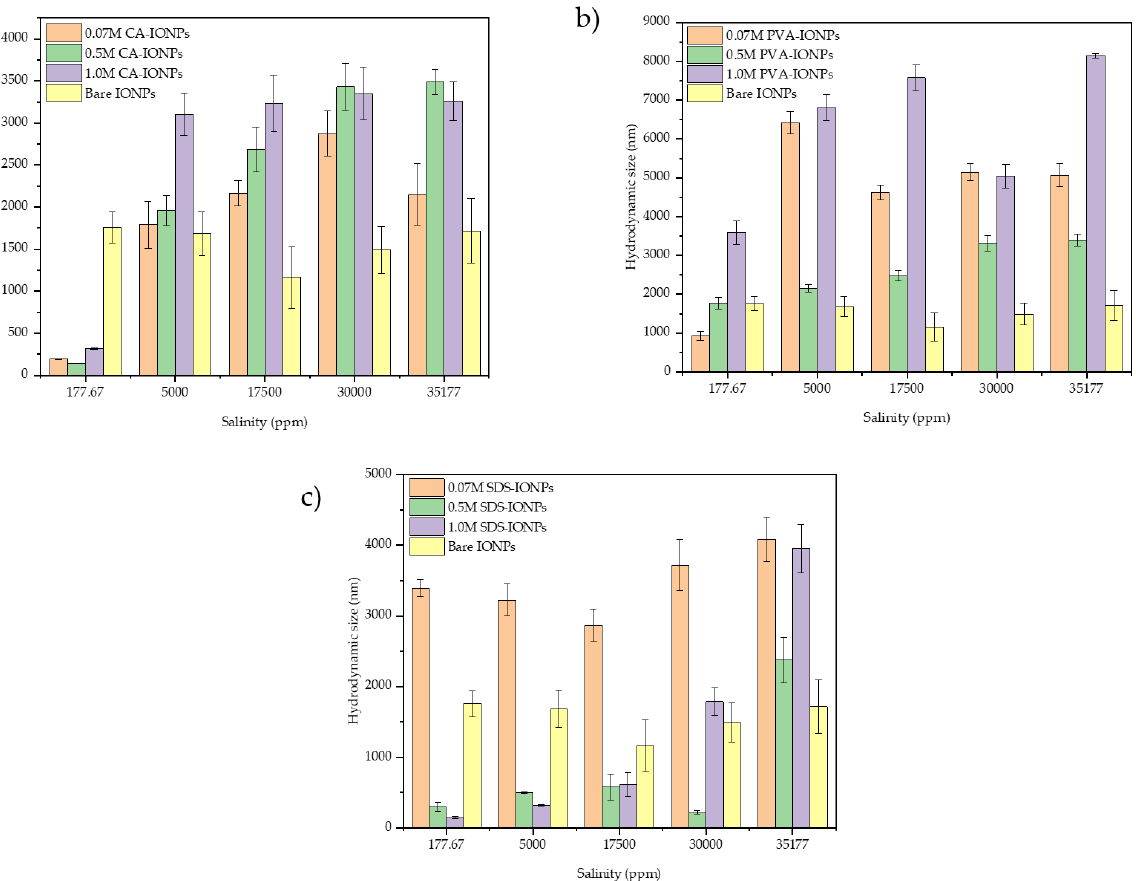
Figure 8. Schematic diagram of ( a ) No repulsion, ( b ) electrostatic repulsion and ( c ) steric repulsion. Published in 2020 by Elsevier under Creative Commons Attribution 4.0 (CC-BY-NC-ND 4.0) License.